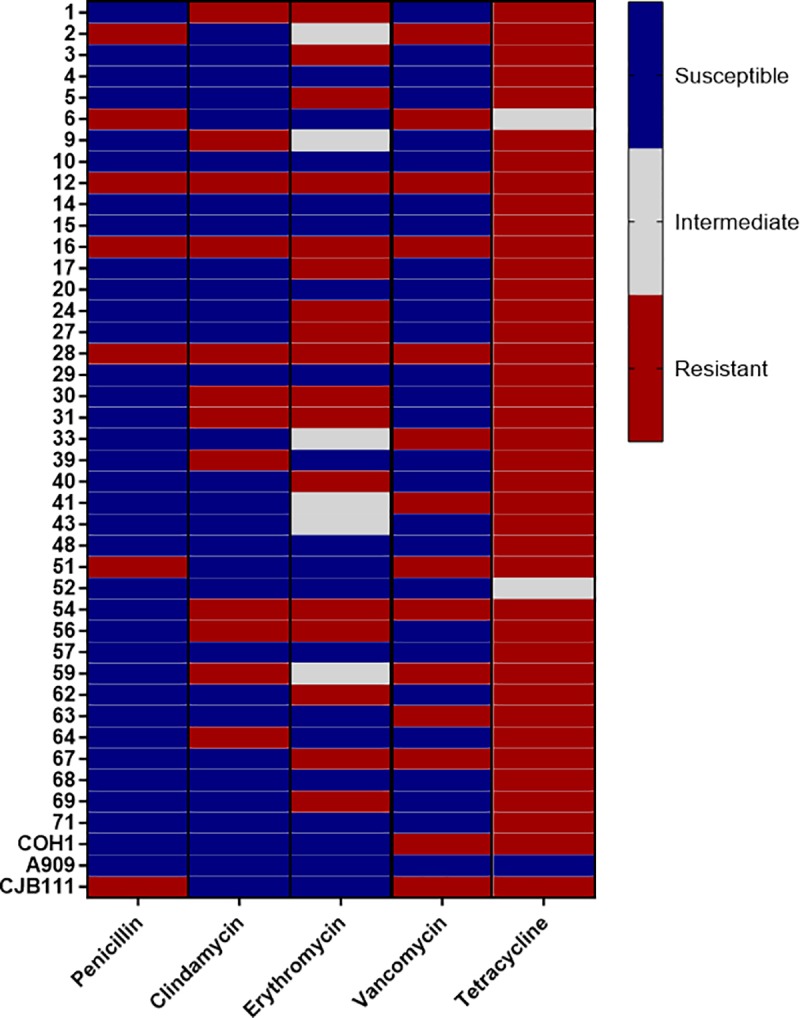
Antibiotic sensitivity of isolate panel.Antibiotic suscpetibility profiles (determined by disc diffusion measurement) displayed in a heat map with blue boxes indicating susceptible isolates, gray boxes indicating intermediate isolates, and red boxes indicating resistant isolates. Antibiotic discs were used at the following concentrations: penicillin 10 U, clindamycin 2 mg, erythromycin 15 mg, vancomycin 30 μg, and tetracycline 30 μg.